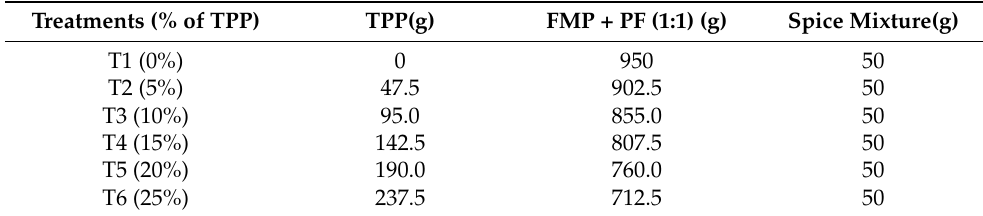
Table 1. Formulations of the various treatments for one kg mix of RTC-GF snack. Treatments (% of TPP) TPP(g) FMP + PF (1:1)